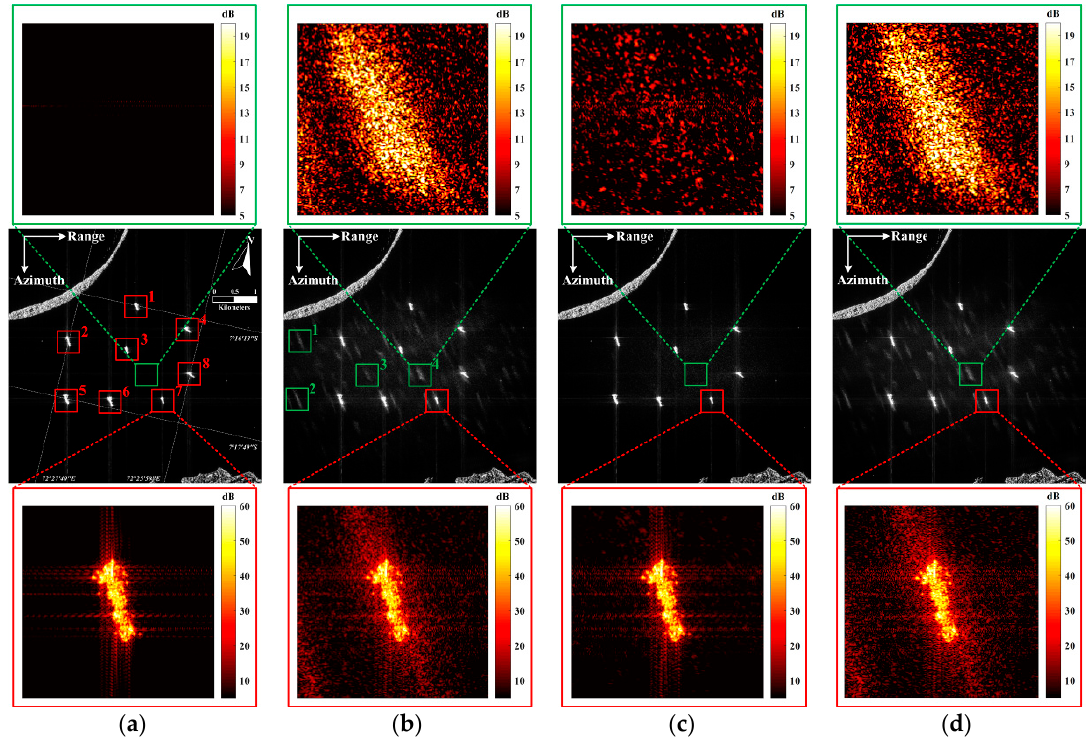
Figure 16. Simulation based on real focused data. The original image is from the SLiding spotlight (SL)